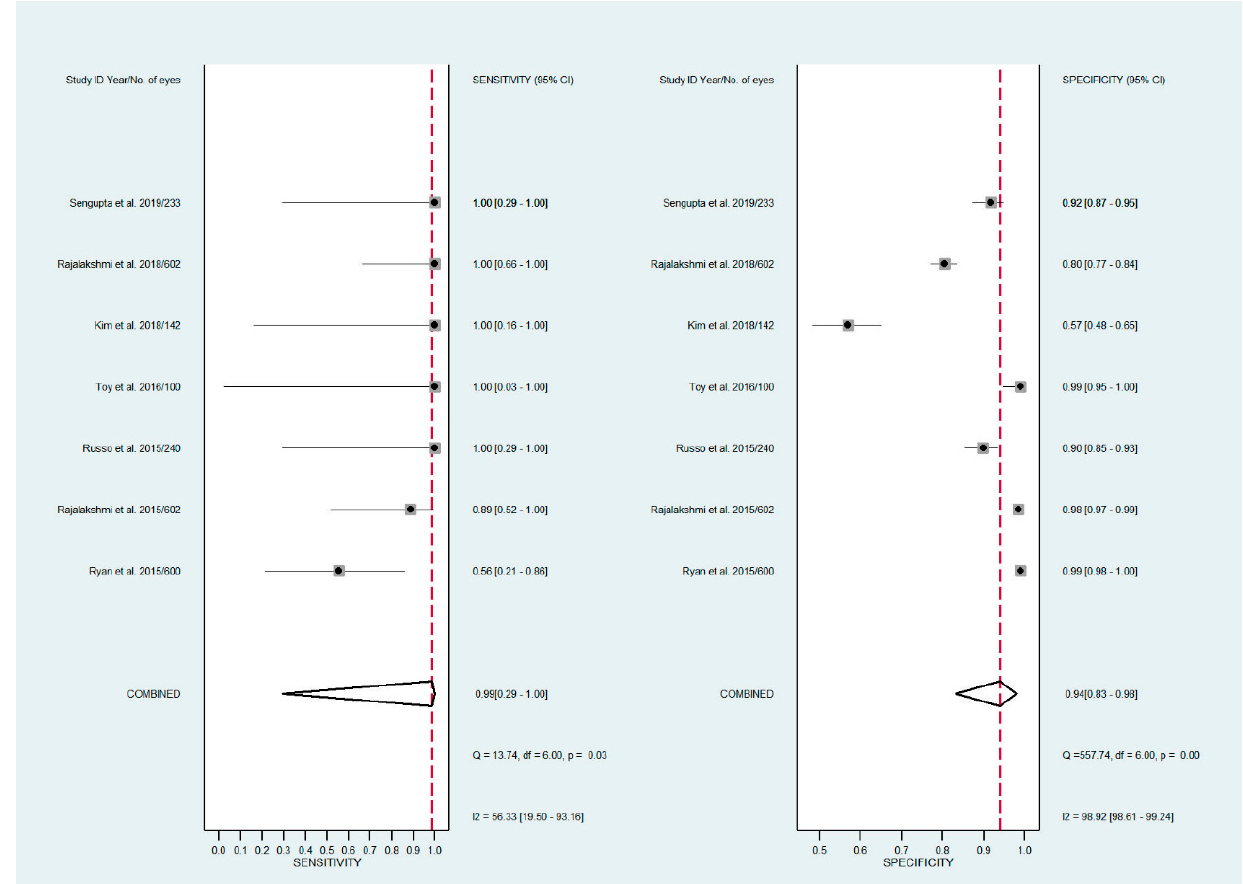
Figure 5. Forest plots for the sensitivity and specificity of smartphone-based fundus imaging.